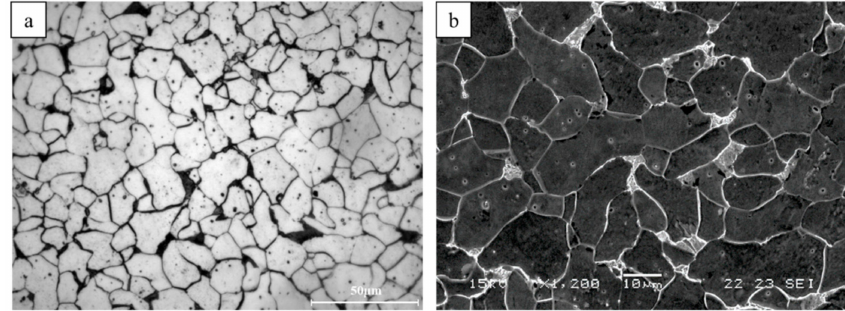
Figure 4. Typical microstructure of the reference ST-37 alloy ( a ) optical microscopy, ( b ) SEM observation. X-ray di ff raction analysis of the printed ER70S-6 alloy and its reference ST-37 alloy is shown